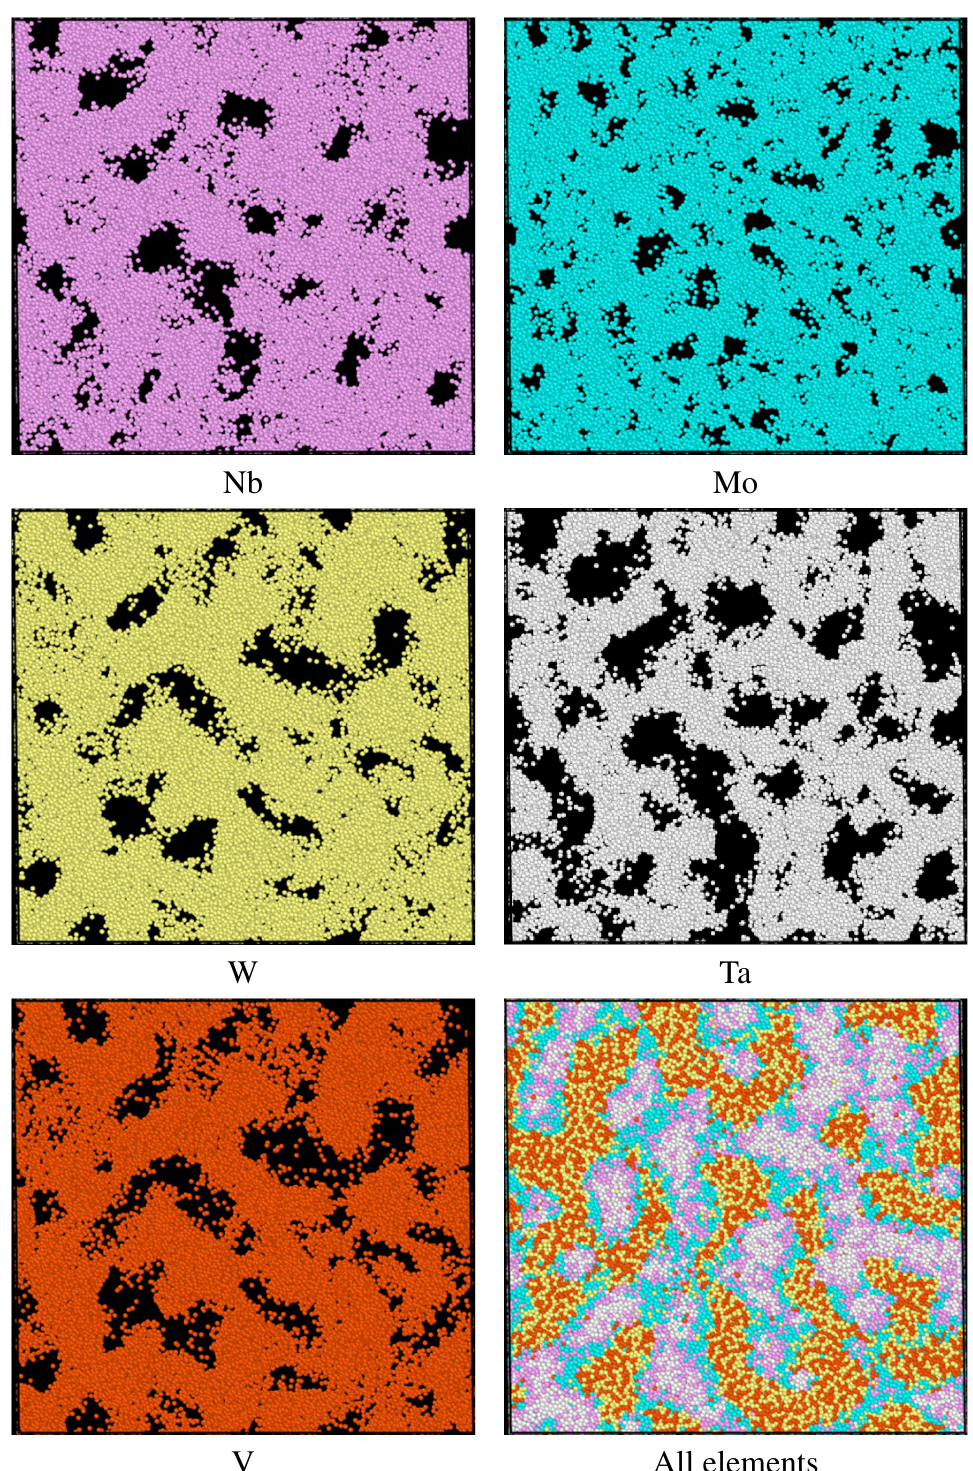
Figure 9. The distributions of Nb, Mo, Ta, W, V, and all elements within the single crystal